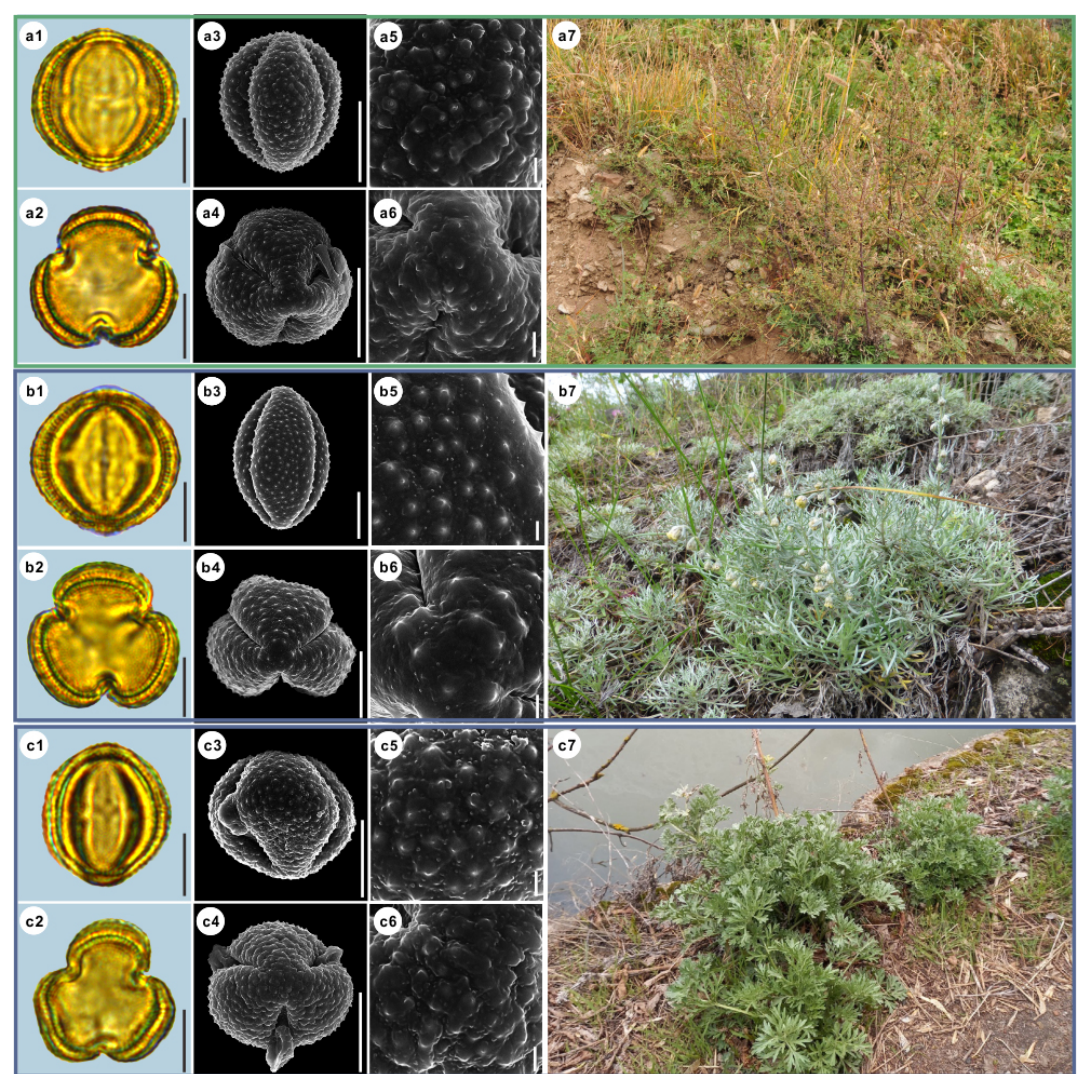
Figure 10. Pollen grains and the habitats of their source plants. (a) Artemisia rupestris ; (b) Artemisia sericea ; and (c) Artemisia absinthium . Pollen grains in equatorial view under LM (a1, b1, c1) and SEM (a3, a5, b3, b5, c3, c5) , in polar view under LM (a2, b2, c2) and SEM (a4, a6, b4, b6, c4, c6) , along with the habitats of their source plants (a7 provided by © Bo-Han Jiao, b7 cited from https://www.inaturalist. org/photos/48033353, last access: 19 August 2022, by © svetlana_katana, c7 cited from https://www.inaturalist.org/photos/123569286, last access: 19 August 2022, by © ) . Scale bar in LM and SEM overview 10µm, and in SEM close-up